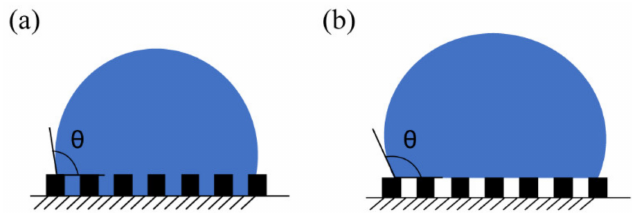
Figure 1. Hydrophobic surface models: ( a ) Wenzel model and ( b ) Cassie model.